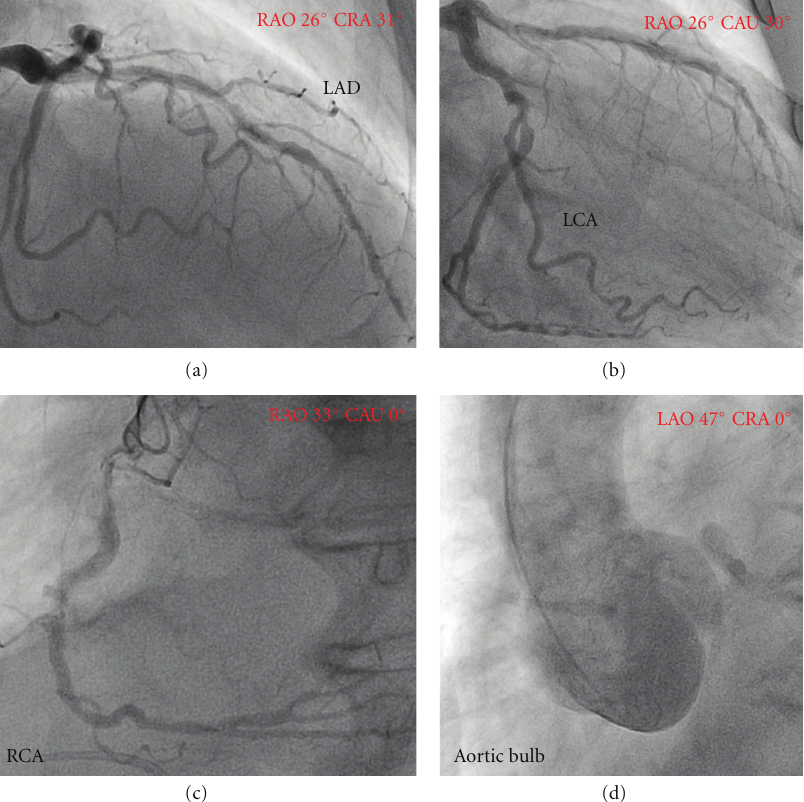
Figure 2: Severe coronary three-vessel disease (a)–(c) and annuloaortic ectasia (d) revealed in cardiac catheter. (LAD: left anterior descending, LCX: left circumflex artery, RCA: right coronary